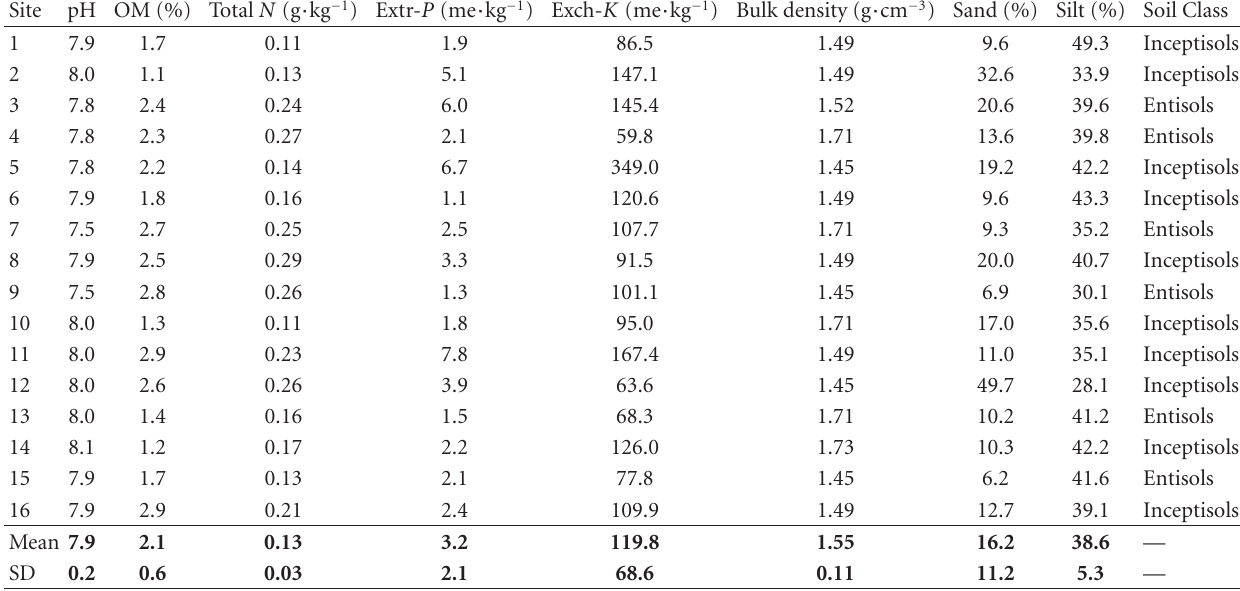
Table 5: Soil physical and chemical analysis from farmers’ cooperators sites.